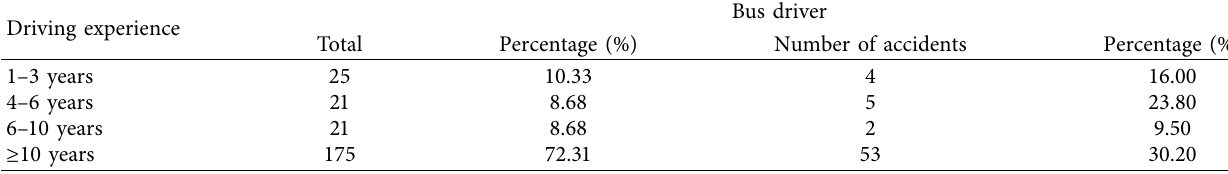
Table 6: Driving experience distribution.